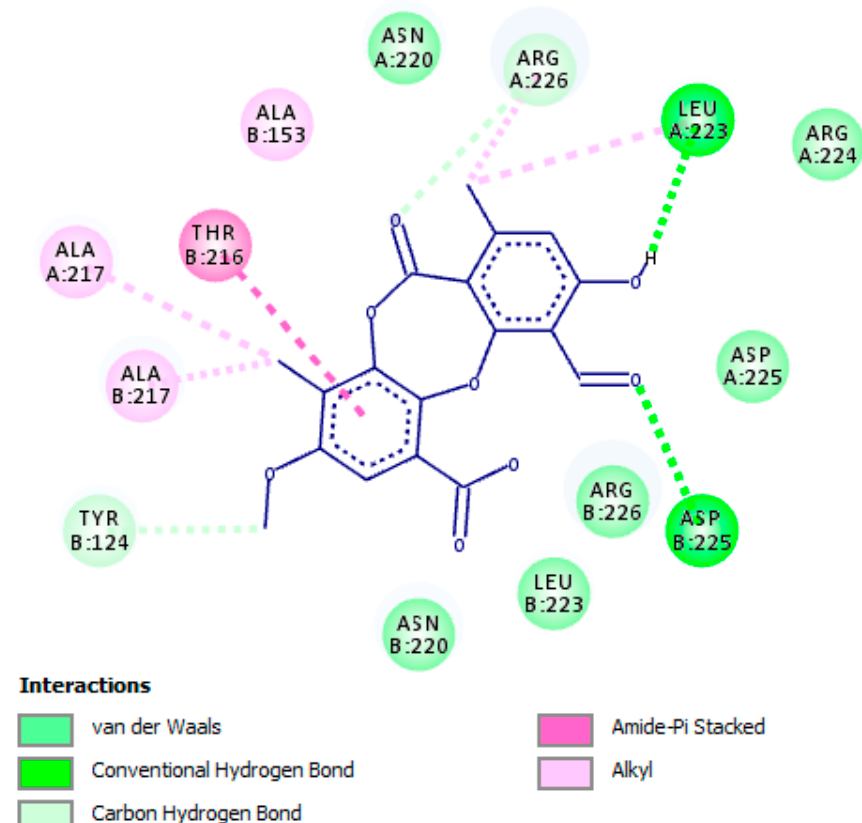
Figure 3. Molecular surface depiction of HSV-2 protease. As shown, psoromic acid binds remarkably to the active site of the enzyme.